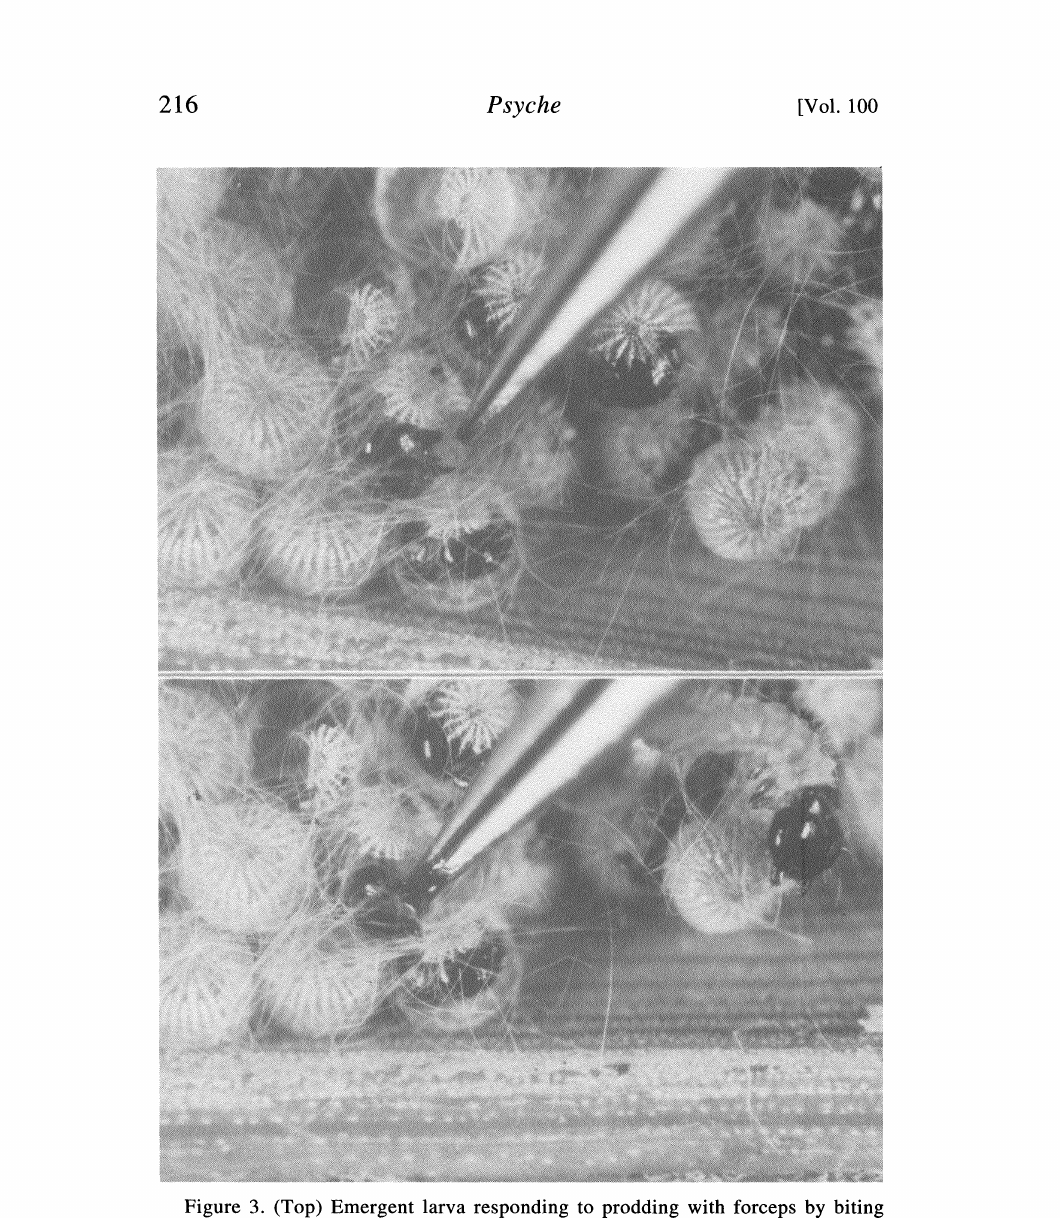
Figure 3. (Top) Emergent larva responding to prodding with forceps by biting with its mandibles. (Bottom) Same, showing larva regurgitating directly upon the contacting